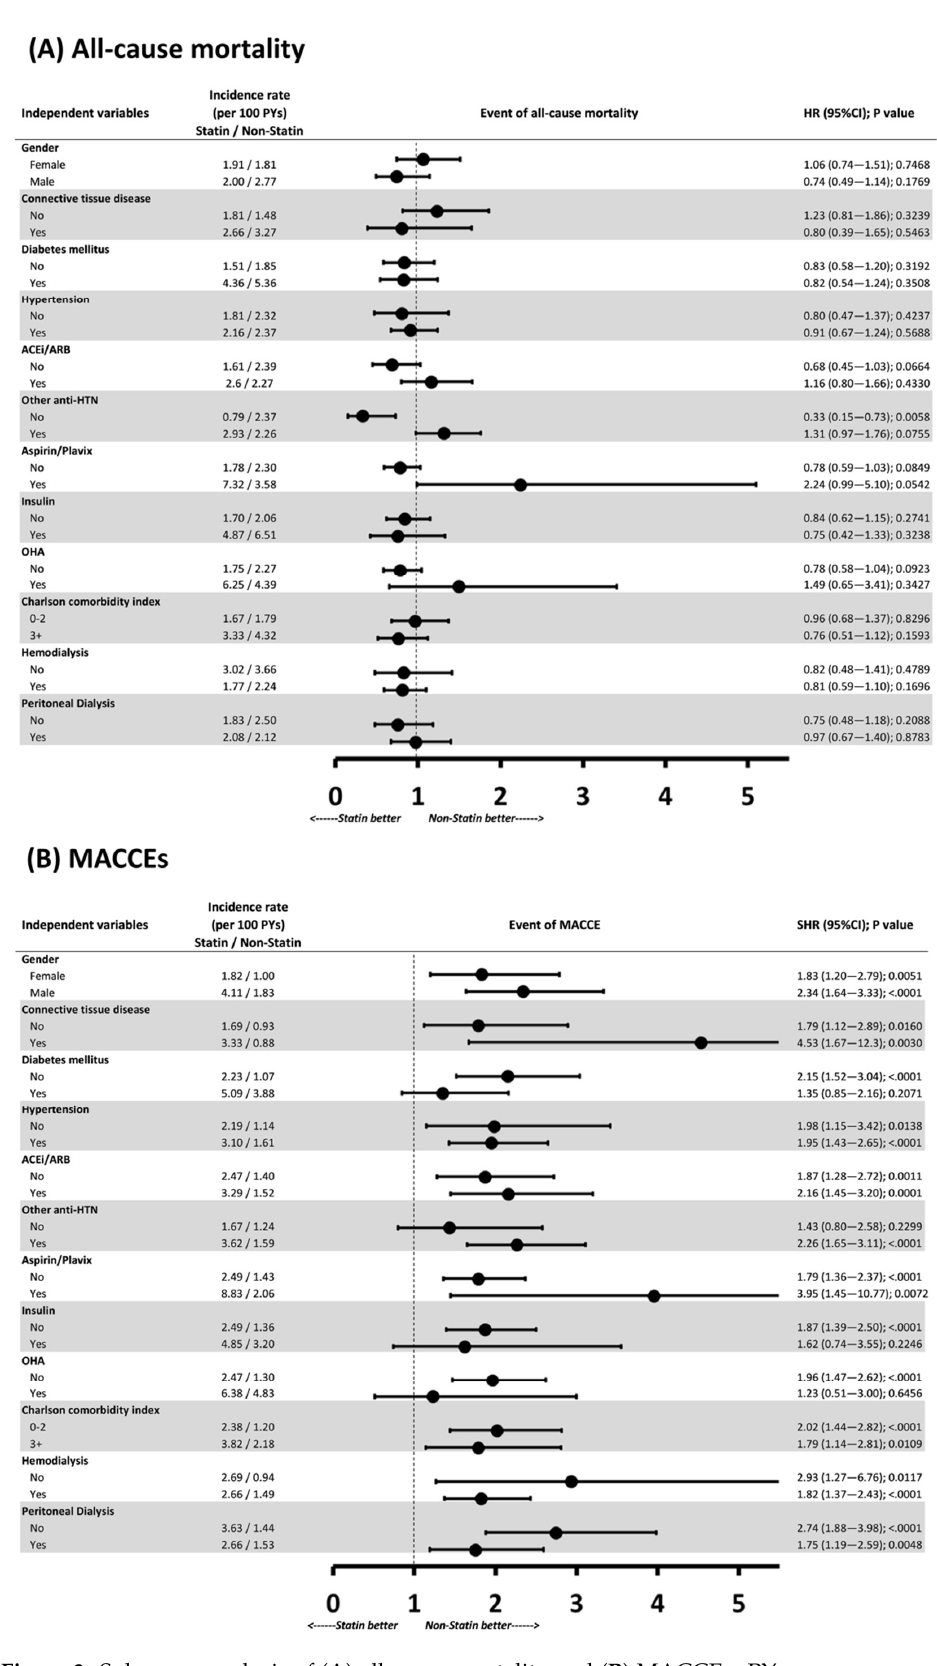
Figure 3. Subgroup analysis of ( A ) all-cause mortality and ( B ) MACCEs. PYs: person-years; HR: hazard ratio; SHR: subdistribution hazard ratio.